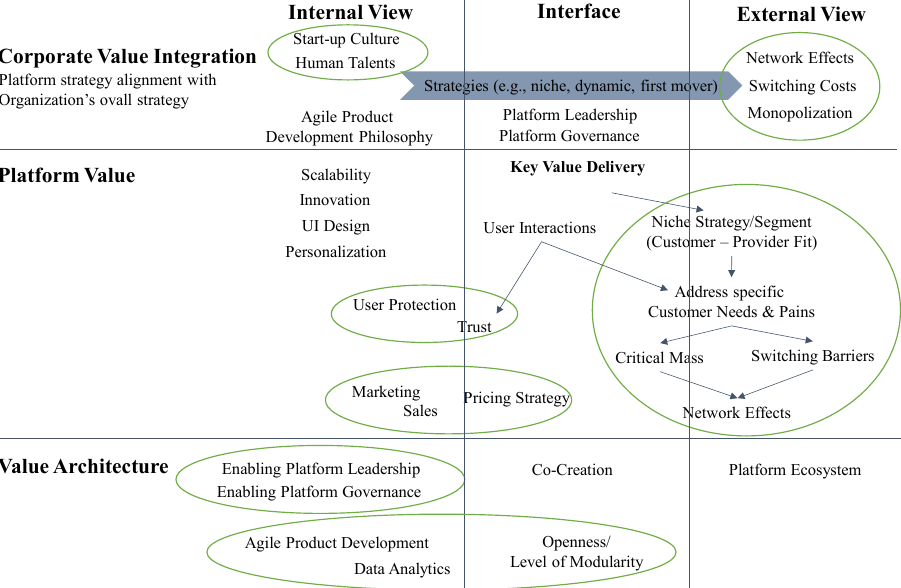
Figure 1. Overview and dependencies of the identified platform success